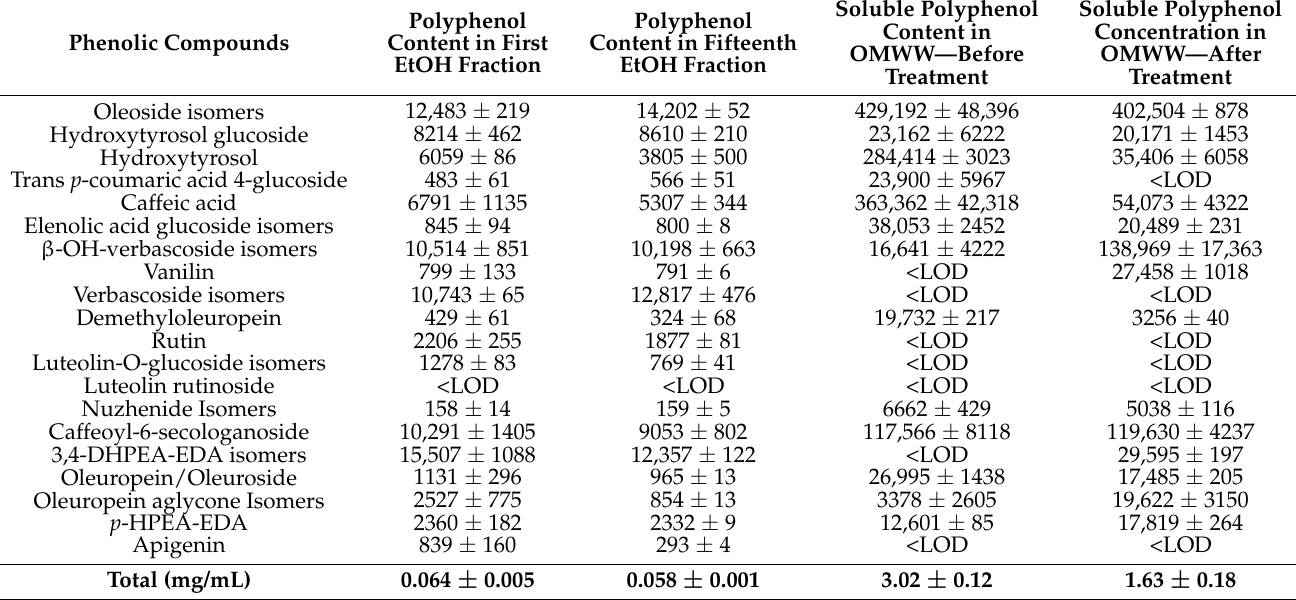
Table 3. Polyphenol quantities for fifteen subsequent treatments of OMWW with Fe 3 O 4 particles modified with C18 silica gel. The particles were thereafter desorbed in EtOH. Total concentrations of polyphenolic compounds are quantified in mg per mL of OMWW; individual compounds are semi-quantified (using counts from the MS